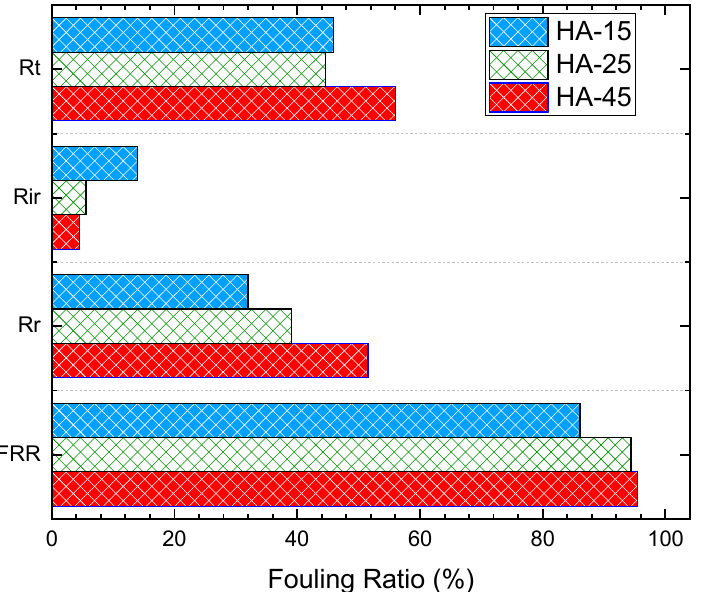
Figure 10. Calculated fouling ratios at increasing HA concentrations of 15, 25, and 45 ppm.